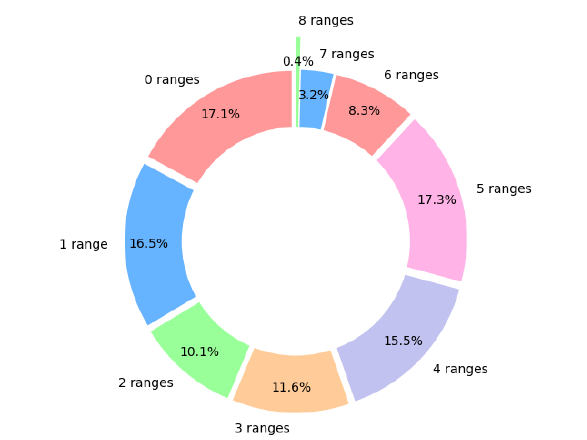
Figure 4. Number of available ranges in a loop (percentage of the cases).